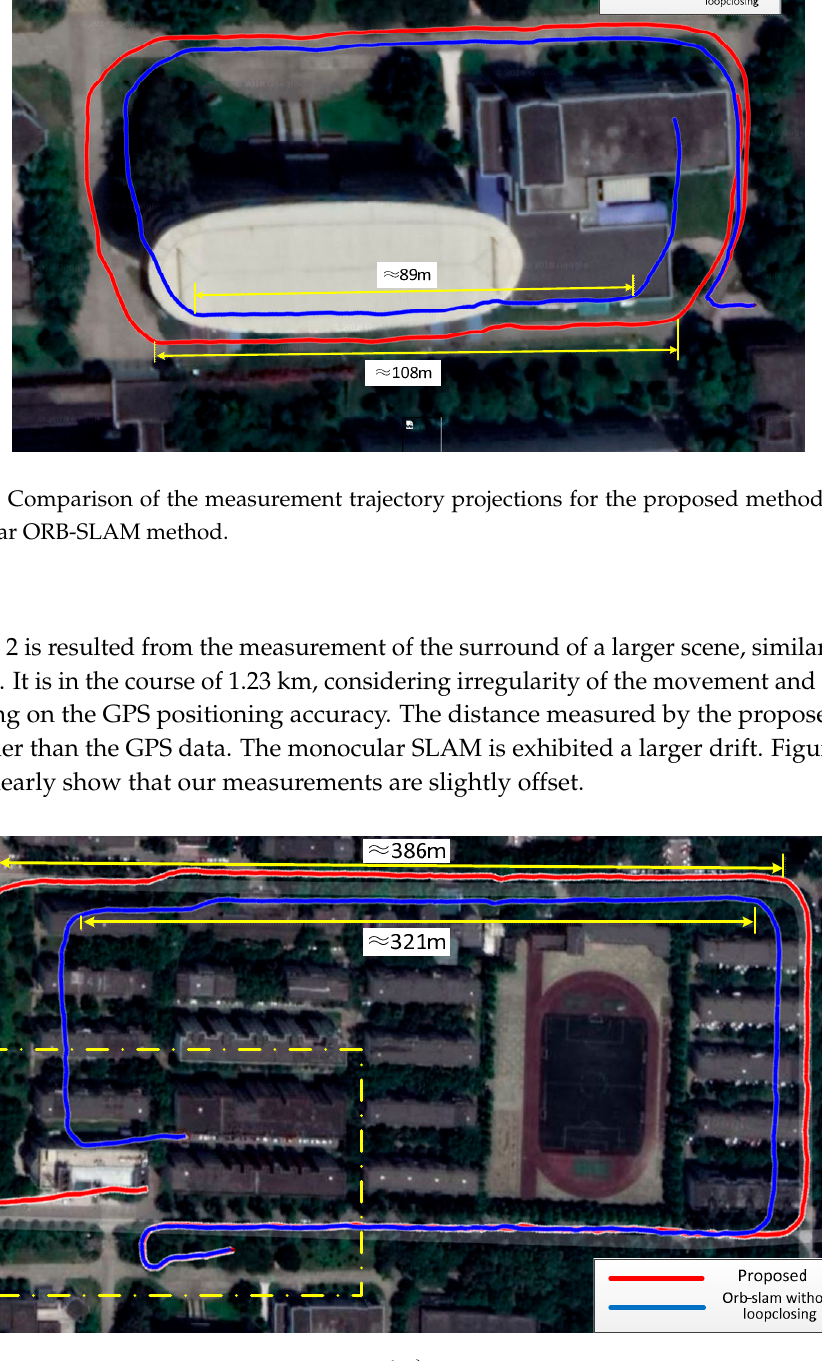
Figure 8. Comparison of the measurement trajectory projections for the proposed method and the Monocular ORB-SLAM method.